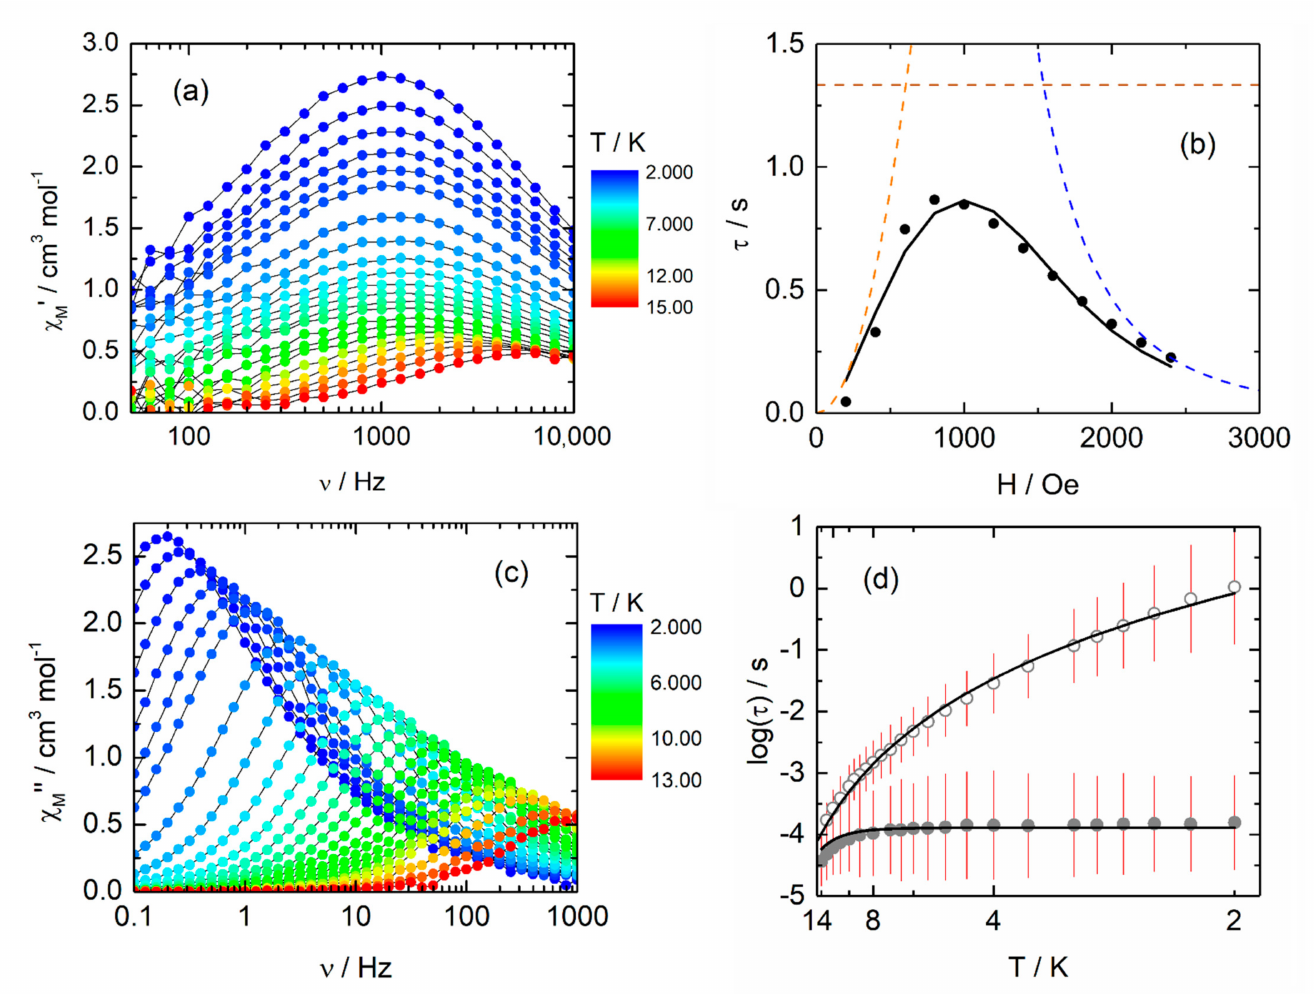
Figure 6. ( a ) Frequency dependence of χ M ” for 2 at 0 Oe in the temperature range 2–15 K ( b ) Field dependence of the relaxation time at 2 K in the field range of 0–3000 Oe for 2 with the best-fitted curve (full black line) with the combination Orbach + Raman (dashed brown line), QTM (dashed orange line) and Direct (dashed blue line) processes; ( c ) frequency dependence of χ M ” for 1 at 1200 Oe in the temperature range 2–13 K; ( d ) temperature dependence of the relaxation time for 2 at 0 Oe (open grey circles) and 1000 Oe (full grey circles) in the temperature range 2–14 K with the best-fitted curve (full black lines) with Raman process only at 1200 Oe and a combination of Raman and QTM processes at 0 Oe. Error lines are calculated using the log-normal distribution model at the 1 σ level